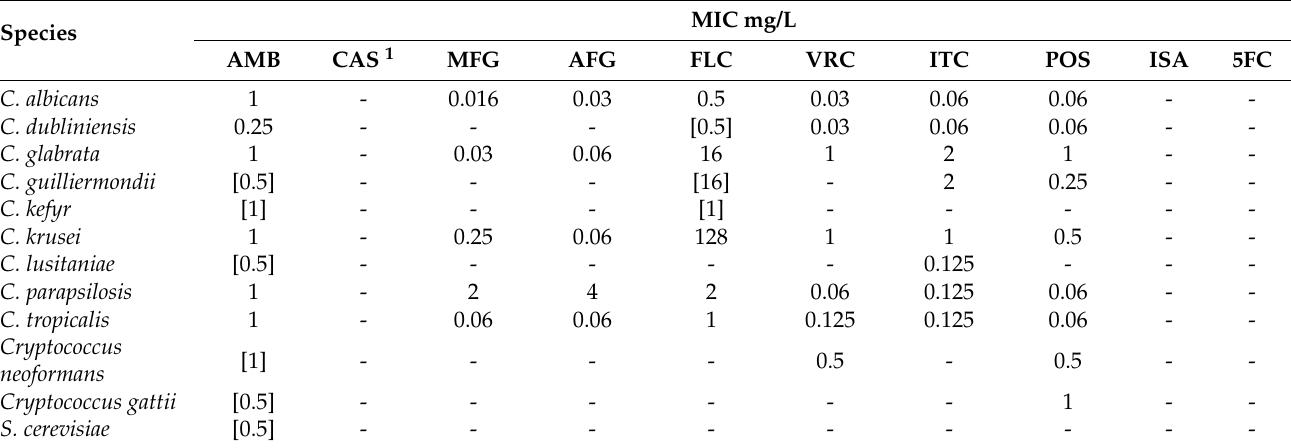
Table 2. Overview of the species and compounds for which EUCAST ECOFFs or tentative ECOFFs (tECOFFs indicated in brackets) have been established for yeast species [1]. A dash denotes that an ECOFF has not been established for that particular organism and